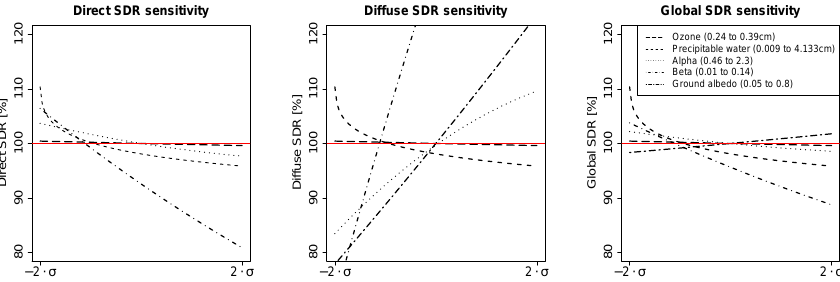
Fig. 5. Local sensitivities of clear-sky direct, diffuse and global SDR to ozone, precipitable water, the ˚Angstr¨om parameters α and β and ground albedo. The sensitivities are estimated for constant path length m r = 2, the value for the mean solar zenith angle at Jungfraujoch. The range of the different parameters are given in the legend. The slope of the different curves reflect the relative sensitivity to each parameter. The mean downward radiation is indicated in red. The x -range is µ − 2 σ to µ + 2 σ avoiding parameter values without physical meaning (cf. Table 2).